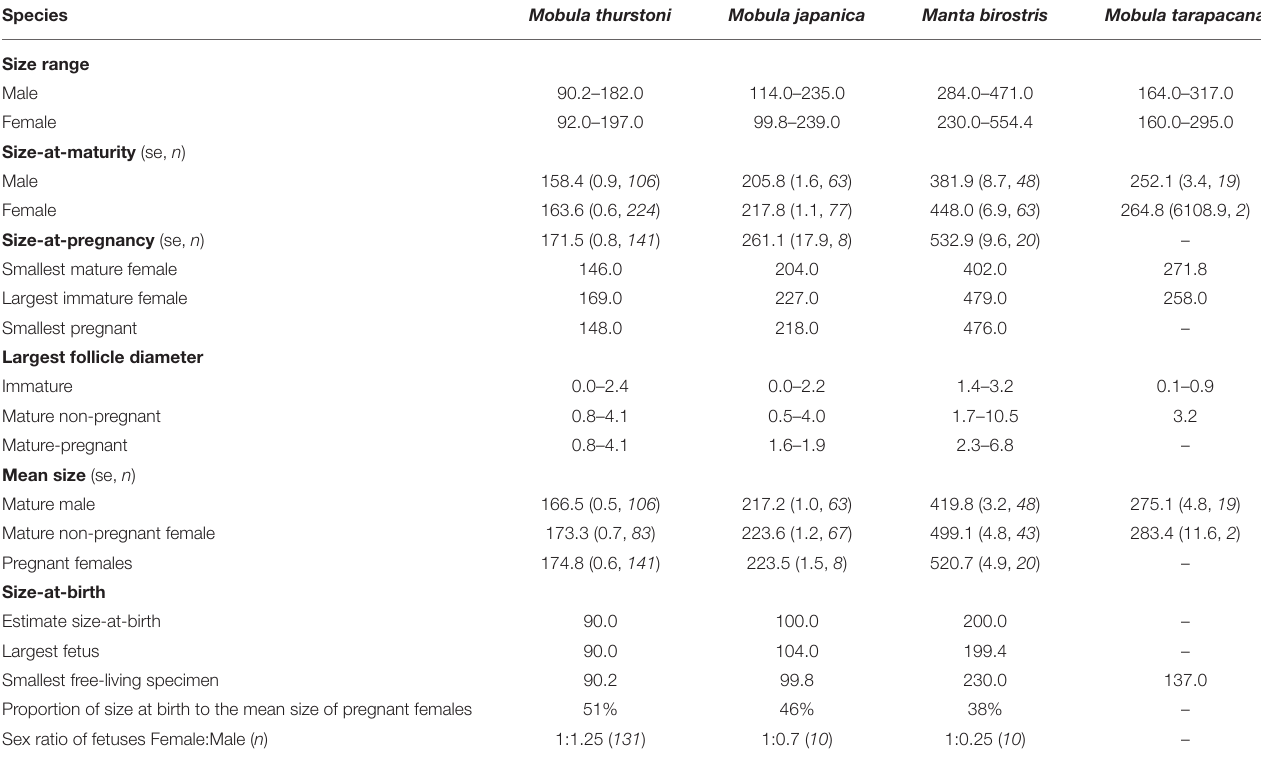
TABLE 2 | Summary of life-history traits and reproductive onset for the four mobulids, in this study.